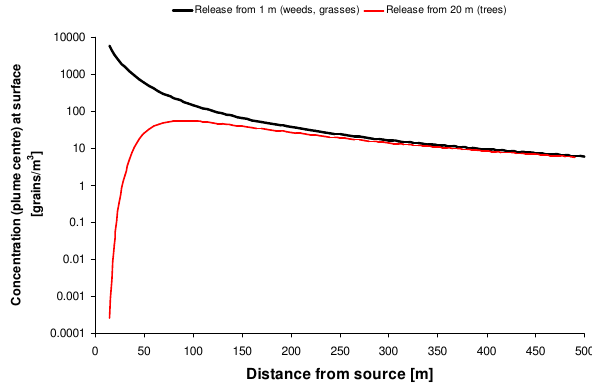
Fig. 1. Local-scale concentration profile of the pollen near the sur- face after the release of 1 mio pollen grains from trees (20m) and weeds/grasses (1m). Overall concentration is calculated using neu- tral meteorological conditions and a wind speed of 5ms − 1